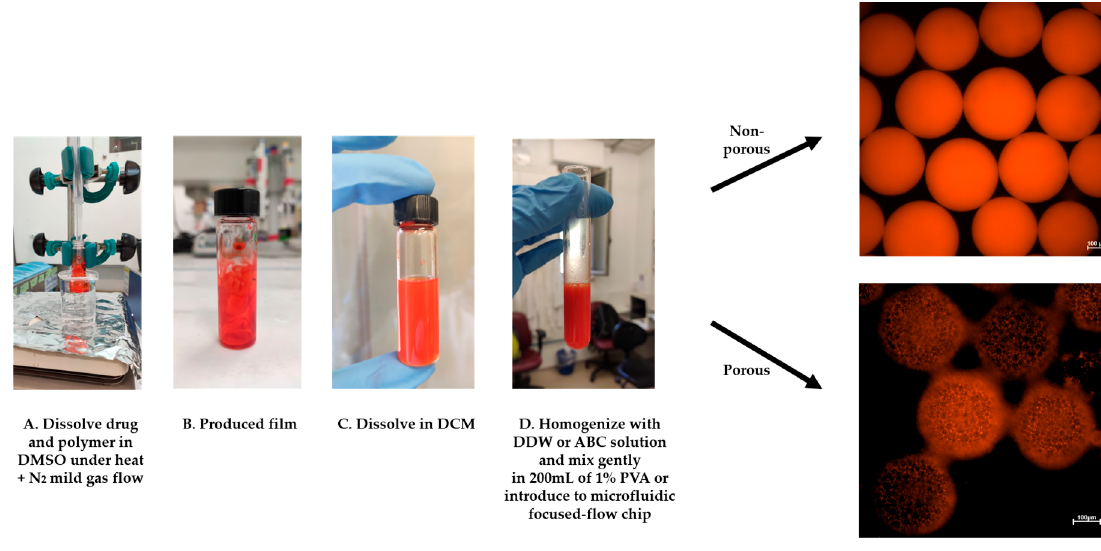
Figure 3. DOX-microsphere (MS) schematic preparation protocol. ( A , B ) The solid phase (DOX+PLA) was prepared using a “bain-marie” setup. ( C ) DCM was added and dissolved on the drug-polymer film, ( D ) followed by homogenization with DDW or 1% ammonium bicarbonate (ABC) solution. Finally, the homogenized emulsion was introduced into the microfluidics-focused flow chip platform or instantly poured into 200 mL of 1% PVA to fabricate solidified